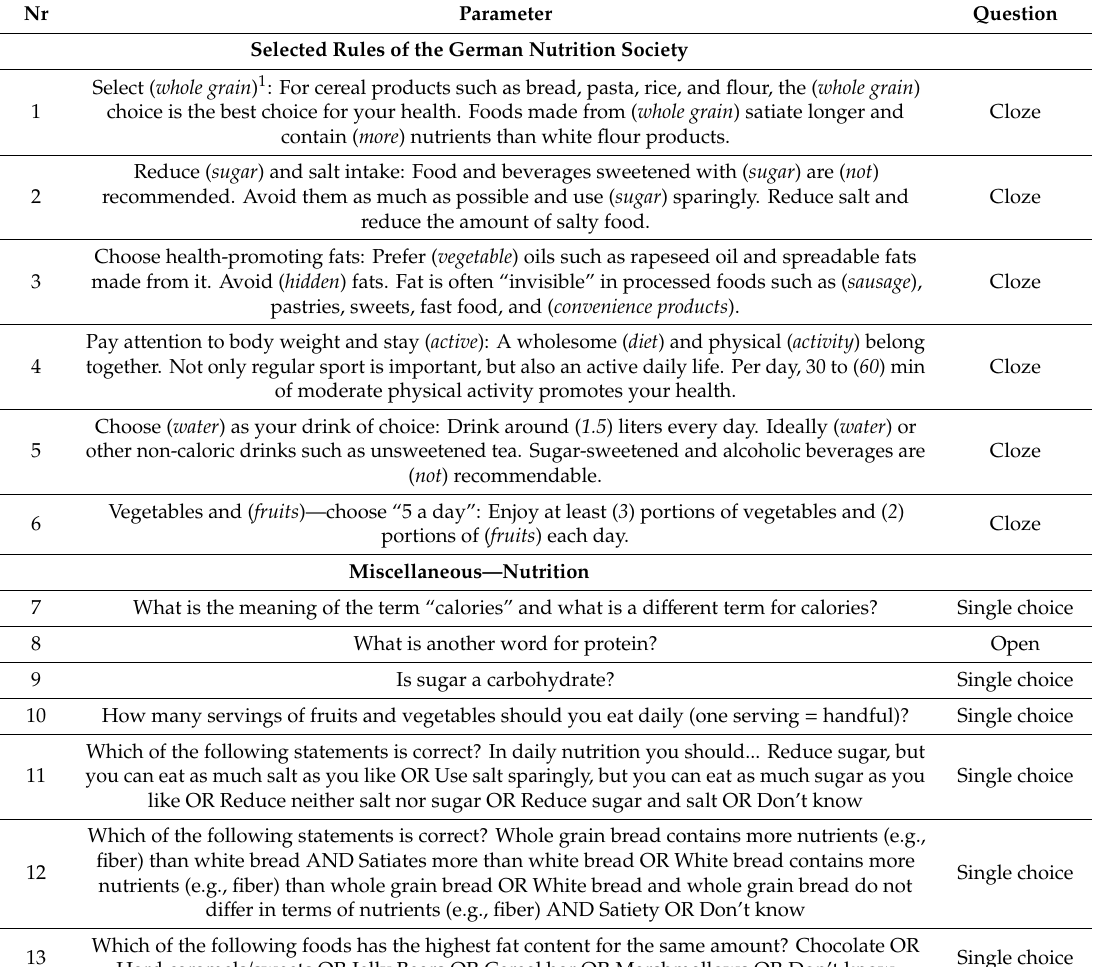
Table 1. Overview of questions related to knowledge of nutrition and physical activity. Parameter